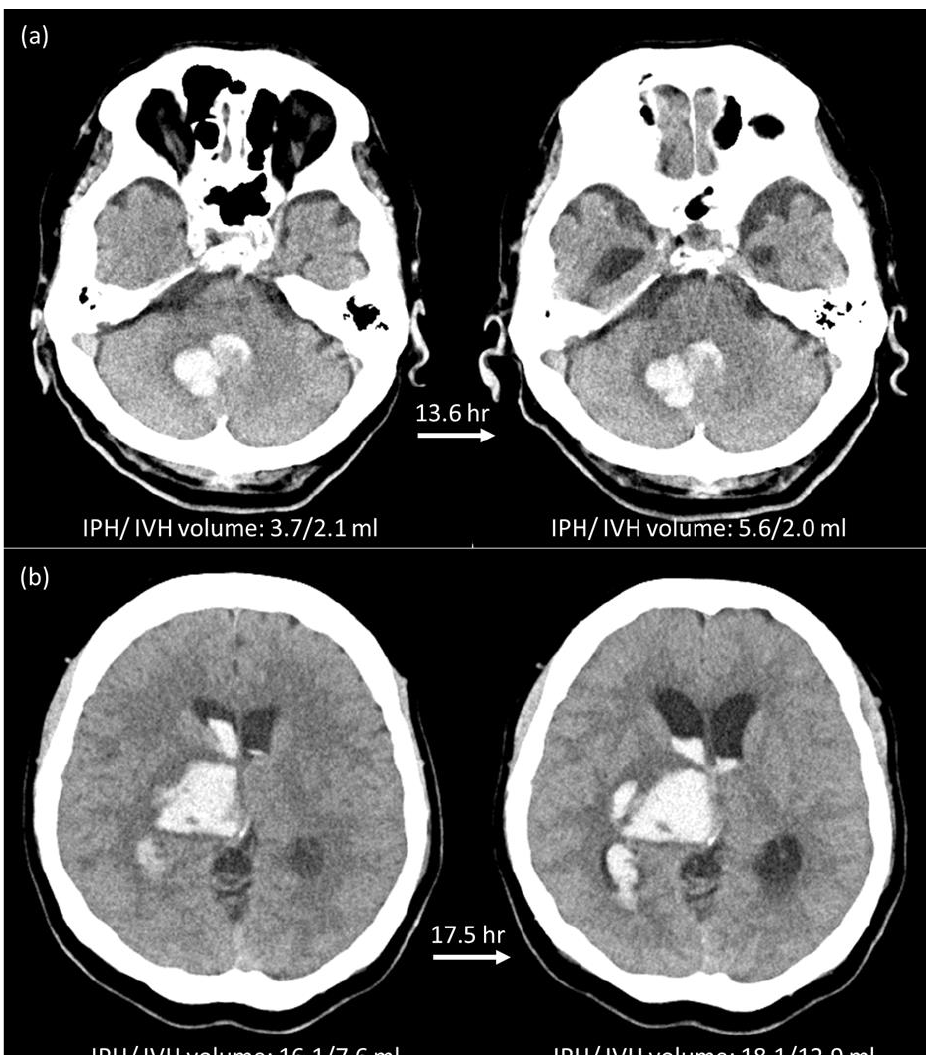
Figure 2. Illustration of two crossover cases. ( a ) A 94-year-old male with right cerebellar hemorrhage was classified as an expander based on IPH (3.7 to 5.6 mL, 51% growth), but was reclassified as a non-expander based on IPH + IVH (5.8 to 7.6 mL, 31% growth < 33% threshold). This patient was discharged on Day-74 after ICH with a mRS of 5. The RM P model showed a true positive result, and the RM P+V showed a true negative result. ( b ) A 52-year-old female with right thalamic hemorrhage was classified as a non-expander based on IPH (16.1 to 18.1 mL) but was re-classified as an expander based on IPH + IVH (23.7 to 31.0 mL, 7.3 mL growth > 6 mL threshold). This patient was